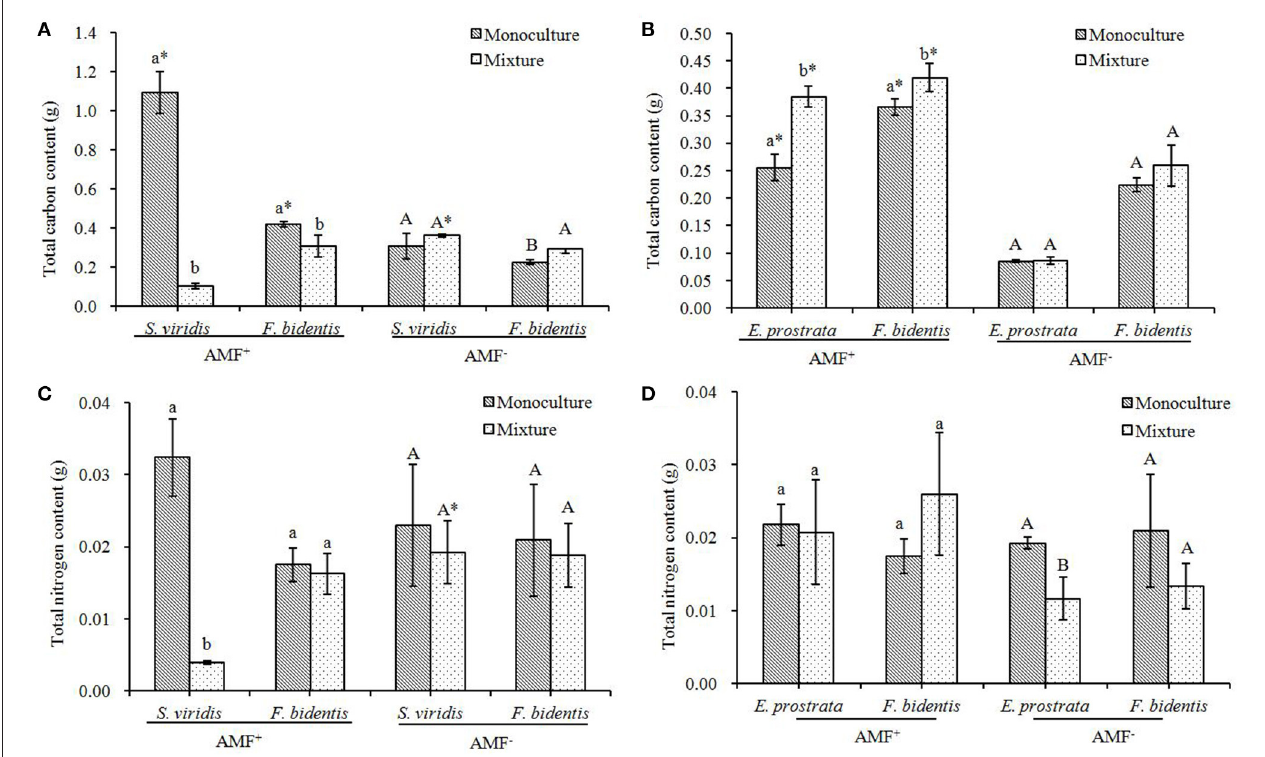
FIGURE 6 | Effects of R. intraradices on the total carbon (A,B) and nitrogen (C,D) content of exotic plant F. bidentis and two native plants S. viridis and E. prostrata when grown in monoculture or in mixture. Different lower case letters indicate significant difference between monoculture and mixture treatments with inoculation of R. intraradices at P < 0.05. Different capital letters indicate significant difference between monoculture and mixture treatments without inoculation of R. intraradices at P < 0.05. *indicate significant difference between inoculation and non-inoculation treatments at P < 0.05. Error bars represent ± SE of mean ( n =